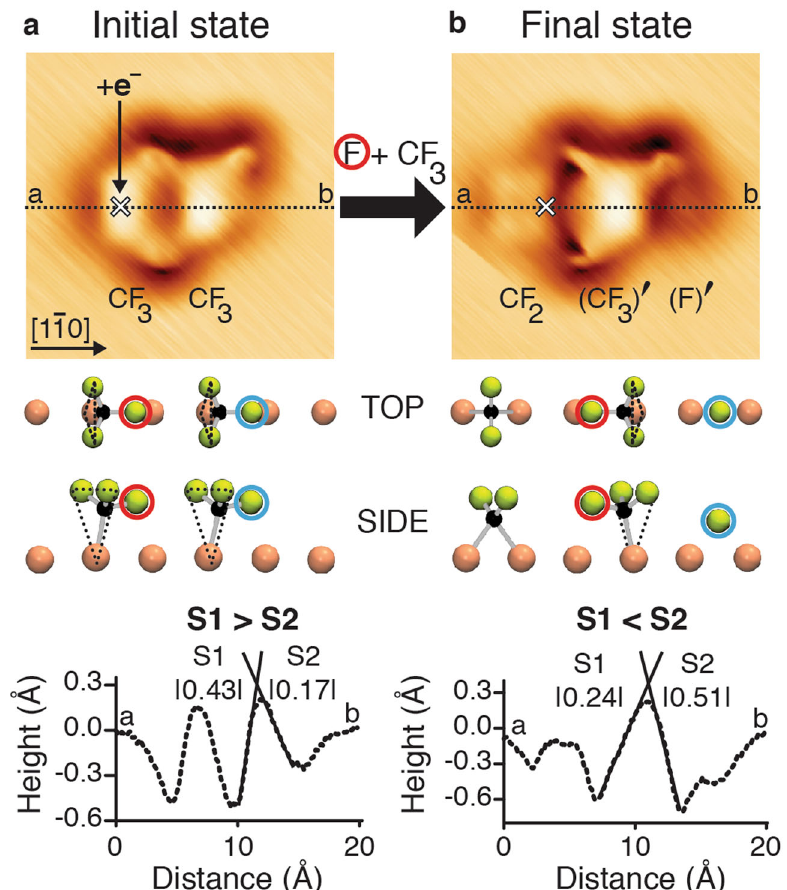
Fig. 2 “ Knock-on ” reaction: F plus CF 3 gives (CF 3 ) ′ plus (F) ′ . a The STM image (20 Å × 20 Å, I = 0.1 nA, V = − 1 mV) of the initial state of a pair of CF 3 molecules, chemisorbed at the Cu(110) surface, before electron addition to the CF 3 “ precursor “ molecule at the left (location marked by the white cross). In the side view, below, both CF 3 are oriented with their backsides at the left (black dashed triangles). In the top and side views (lines two and three), the F- atom at the tip of the CF 3 umbrella of the precursor is circled in red and in blue for the CF 3 target. b The fi nal state STM image (20 Å × 20 Å, I = 0.1 nA, V = − 1 mV) shows the three products of the electron-induced reaction: CF ′ and (F) ′ . In the top and side views, the CF ′ are seen to have an 2 , (CF 3 ) 3 and (CF 3 ) inverted umbrella. The height-pro fi les (bottom panels) are measured along [1 (cid:1) 10] from a to b . The measured slopes of the CF 3 target in a are S1 = |0.43 ± 0.02| Å/Å and S2 = |0.17 ± 0.01| Å/Å. Those of the (CF 3 ) ′ in b are S1 = |0.24 ± 0.01| Å/Å and S2 = |0.51 ± 0.01|